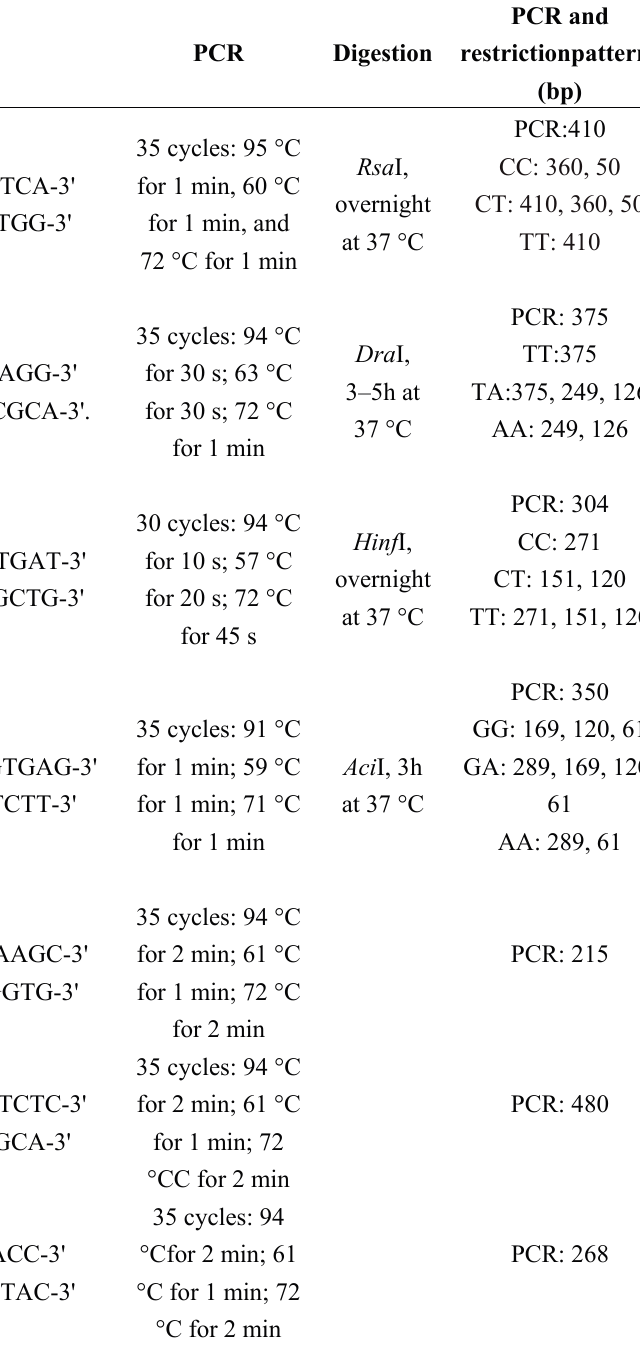
Table 1. Primer sequences, amplification and digestion conditions used in the study.